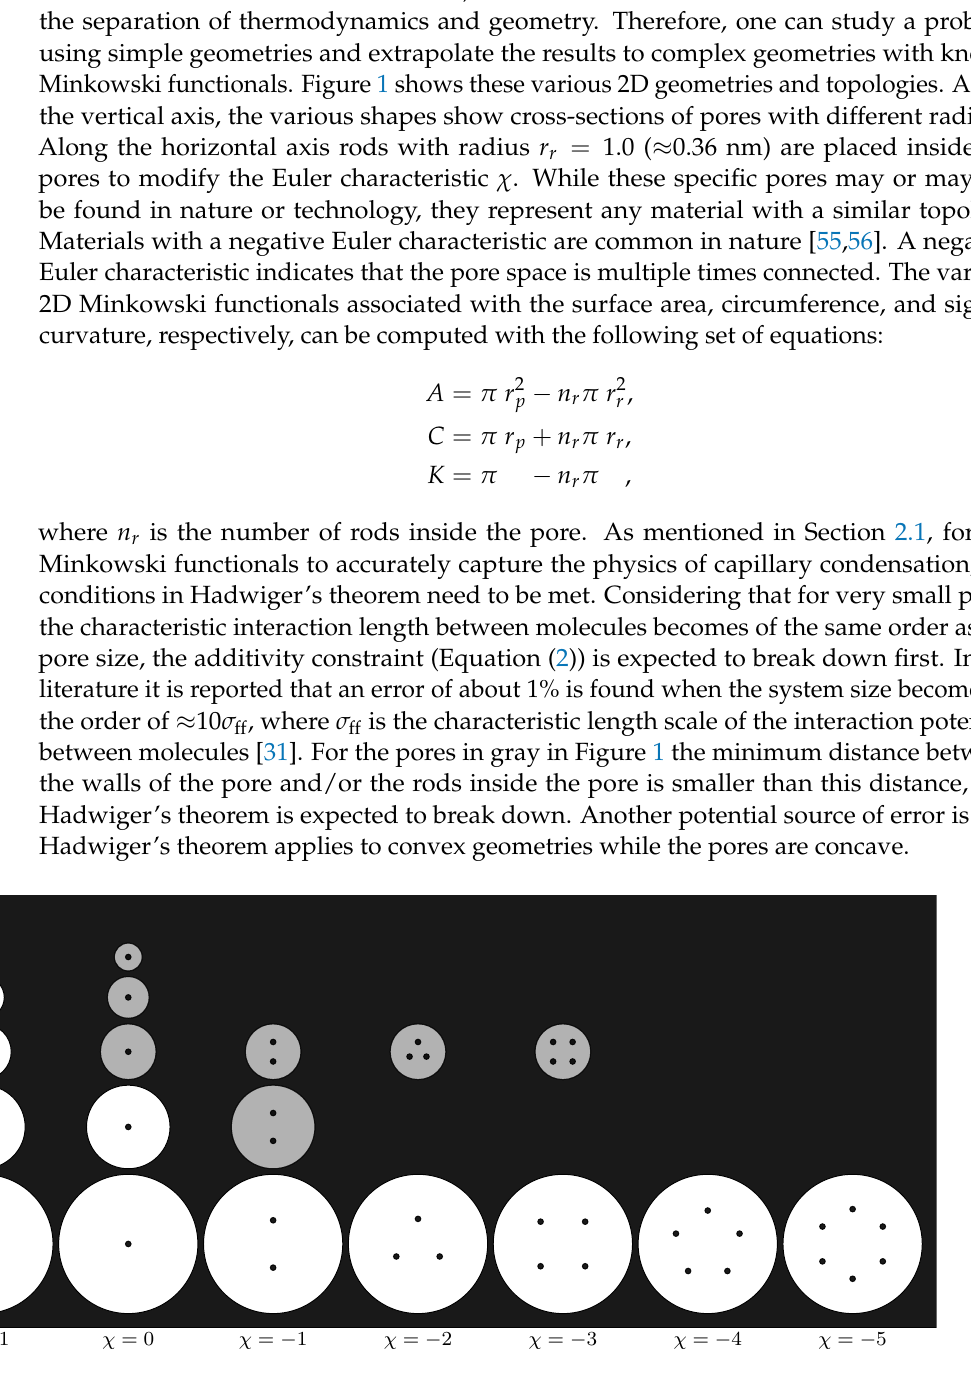
Figure 1. The various 2D geometries and topologies used in the simulations. Along the vertical axis, the various shapes show the cross-section of pores (i.e., disks) with different radii, r p . Along the horizontal axis, rods (i.e., small disks) with radius r p = 1.0 ( ≈ 0.36 nm) are placed inside the pores to modify the Euler characteristic, χ . The open-pore space is colored white and gray. The pores in gray are simulation cases where the distance between walls of either the pores or the rods are smaller than ≈ 10 σ ff , which is the distance at which Hadwiger’s theorem starts to break down